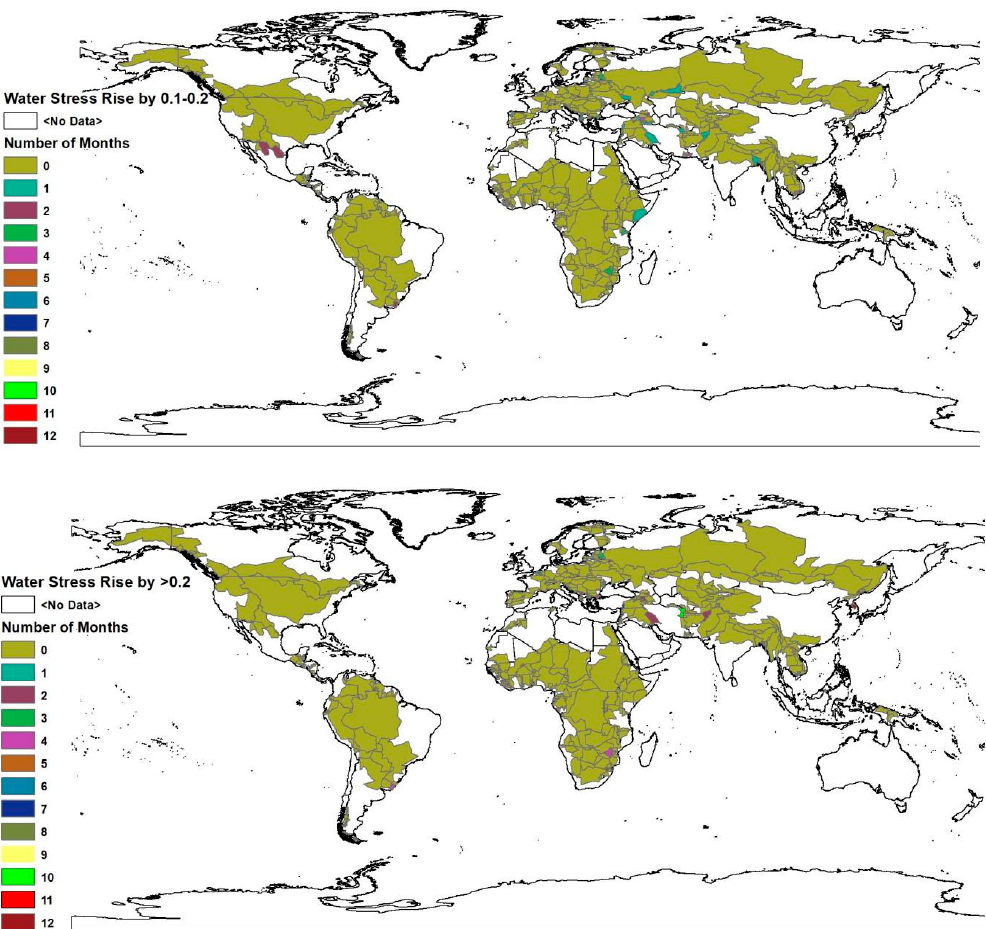
Figure 3. The number of months in which each sub-basin experiences different levels of water stress intensification. This map was generated with ArcGIS 10.2 for desktop from Environmental Systems Research Institute (ESRI) [25].